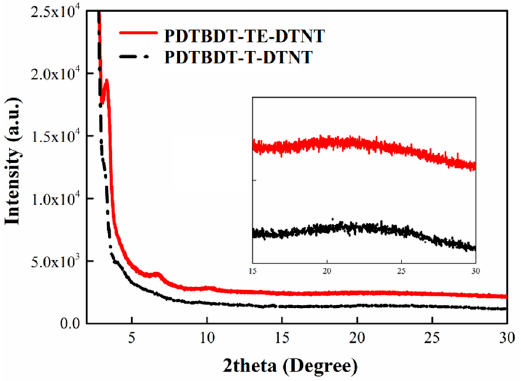
Figure 3. X-ray diffraction patterns of the pristine PDTBDT-TE-DTNT and PDTBDT-T-DTNT films cast from CB onto a glass substrate.